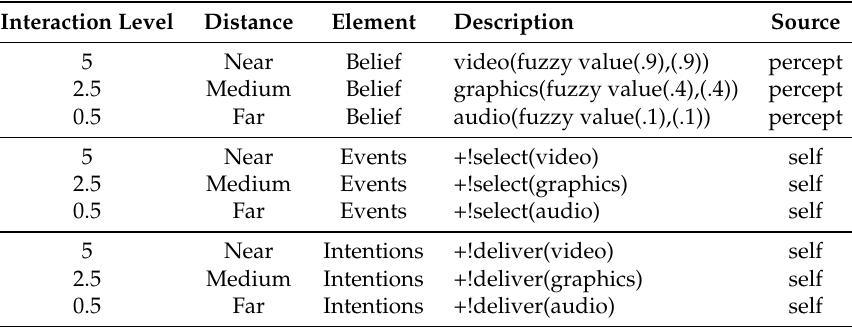
Table 2. Mind state values of exhibition